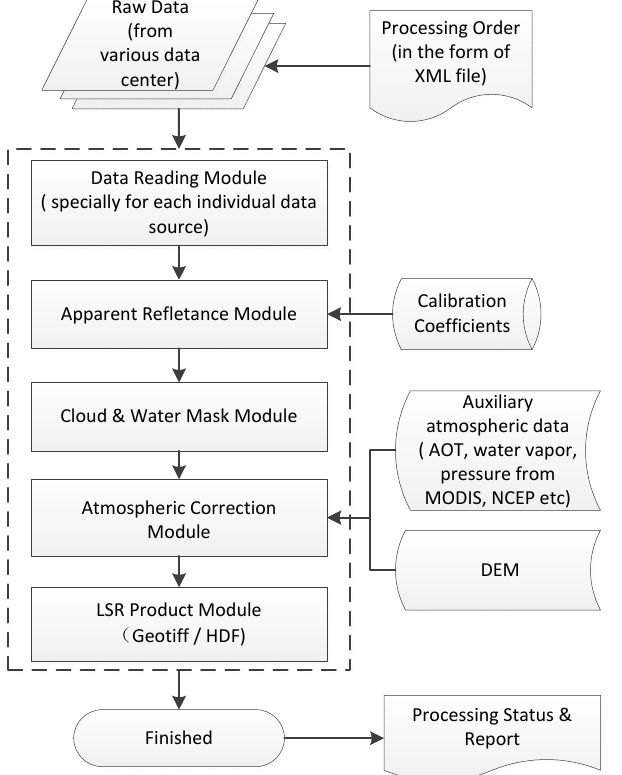
Figure 4. Data processing flow. The modules within the dashed rectangle are the core components of ACFrC.